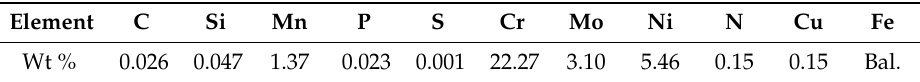
Table 1. The chemical composition (wt %) of DSS 2205.